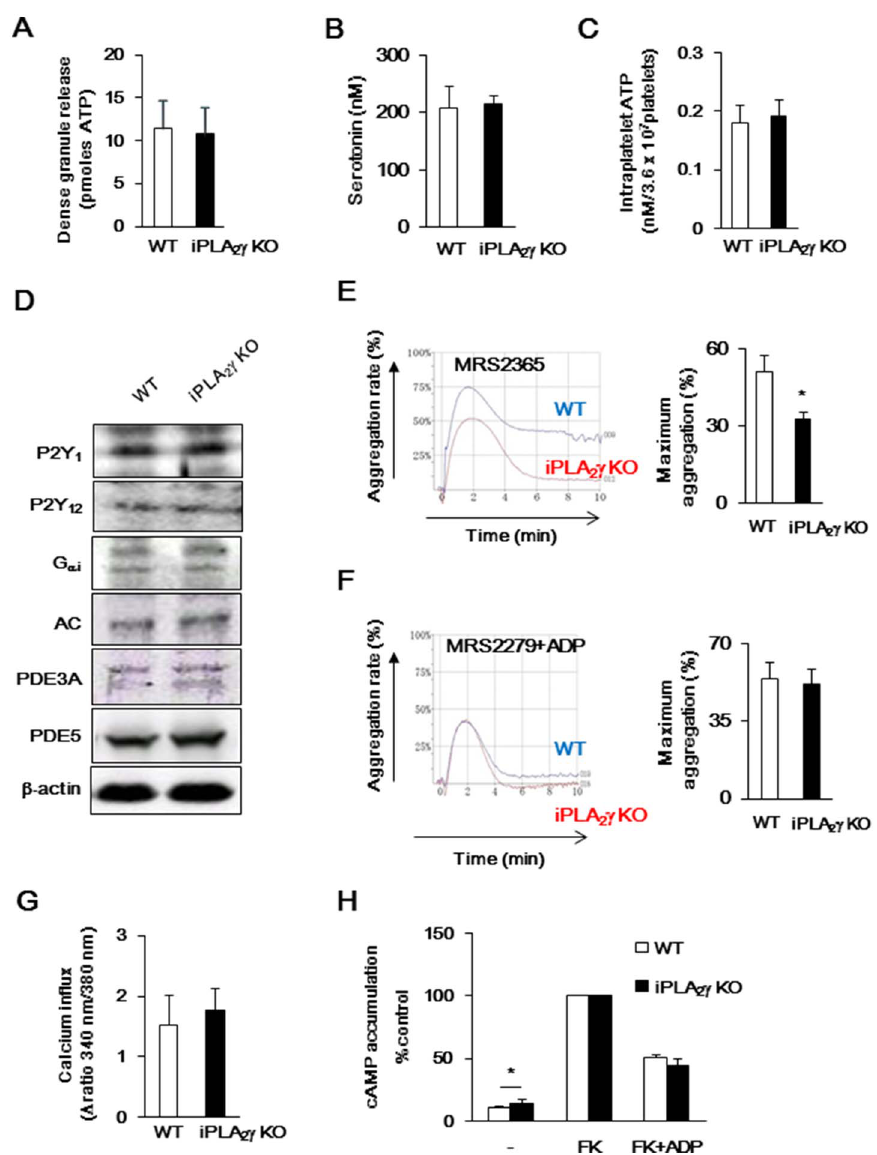
Figure 3. P2Y receptors-mediated signaling of iPLA 2 c deficient platelets. (A and B) Dense granule secretion was evaluated by measuring ATP (A) and serotonin (B) release after the ADP aggregation of WT (open columns) or iPLA 2 c -KO (closed columns) platelets. Results are expressed as the amounts of ATP (n=10–13) and serotonin (n=3–4) released by 3.6 6 10 7 from platelets. (C) Measuring intraplatelet ATP levels of resting state of WT (open columns) or iPLA 2 c -KO (closed columns) platelets (n=5). (D) Protein expression of P2Y 1 , P2Y 12 , G a i , AC and PDEs of platelets from WT and iPLA 2 c -KO mice. b -actin was used as a loading control. Representative results of at least three experiments are shown. (E and F) PRP from WT (blue) or iPLA 2 c -KO (red) mice were stimulated with P2Y 1 agonist (MRS2365) (10 m M) (E) or P2Y 1 antagonist (MRS2279) (10 m M) plus ADP (10 m M) (F), and then light transmission was recorded on an aggregometer. Left panel indicates representative results from aggregometry testing. Right graphs indicate results obtained by aggregometry tests. Results are given as the mean percentage of maximum aggregation 6 SEM (n=6–10). * P , 0.05 between iPLA 2 c -KO and WT. (G) Ca 2 + influx of WT (open columns) or iPLA 2 c -KO (closed columns) platelets in response to ADP (10 m M). Results are given as mean 6 SEM (n=8). (H) PRP (200 6 10 3 / m l) from WT (open columns) or iPLA 2 c -KO (closed columns) was incubated both with and without forskolin (FK; 5 m M) for 30 s before ADP (10 m M) was added and the samples were incubated for 5 min at room temperature. Results are given as the mean 6 SEM (n=5). * P , 0.05 between iPLA 2 c -KO and